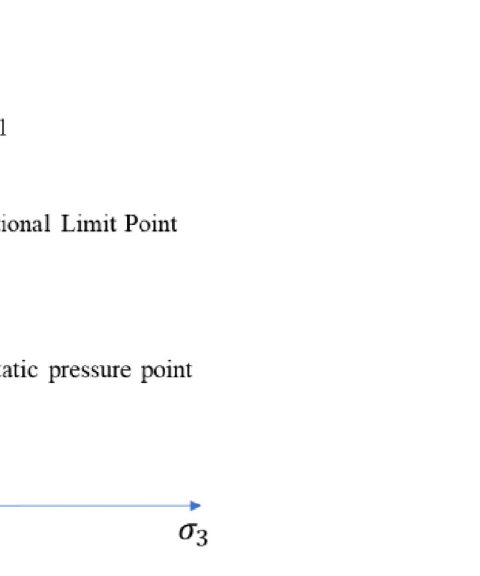
Fig 1. Stress path diagram of unloading